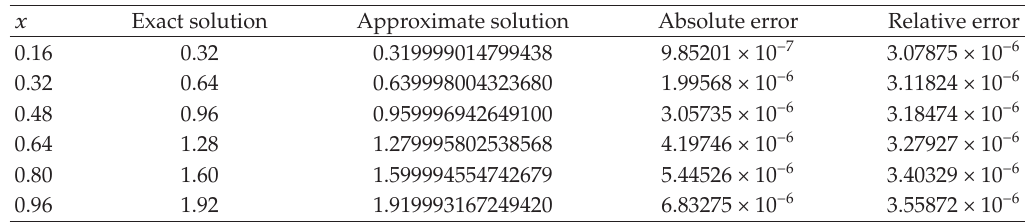
Table 2: Numerical results of u (cid:2) (cid:3) x (cid:4) for Example